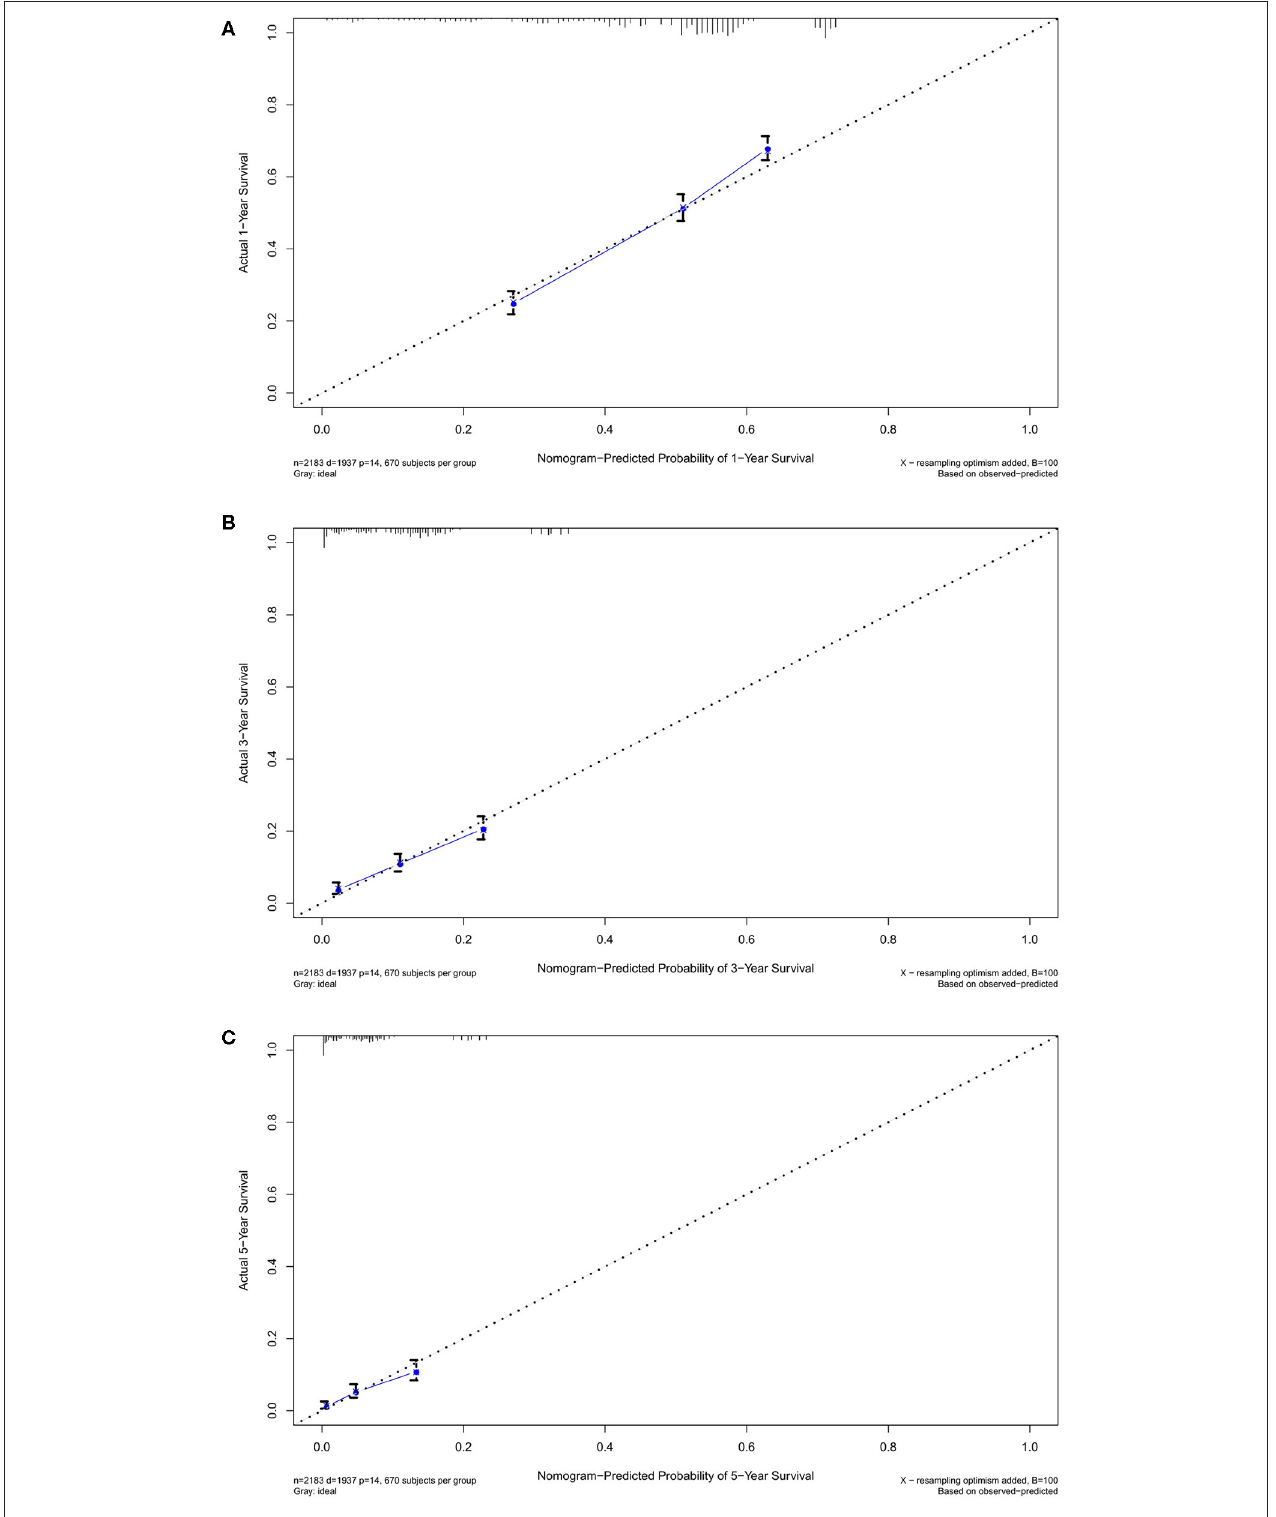
FIGURE 4 | The calibration curves in training cohort. The calibration curves of the nomogram predicting (A) 1-year, (B) 3-years, and (C) 5-years OS.